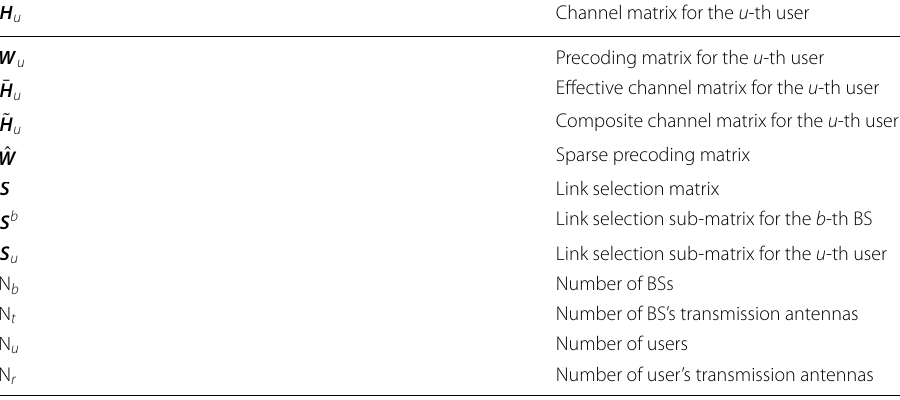
Table 1 List of main